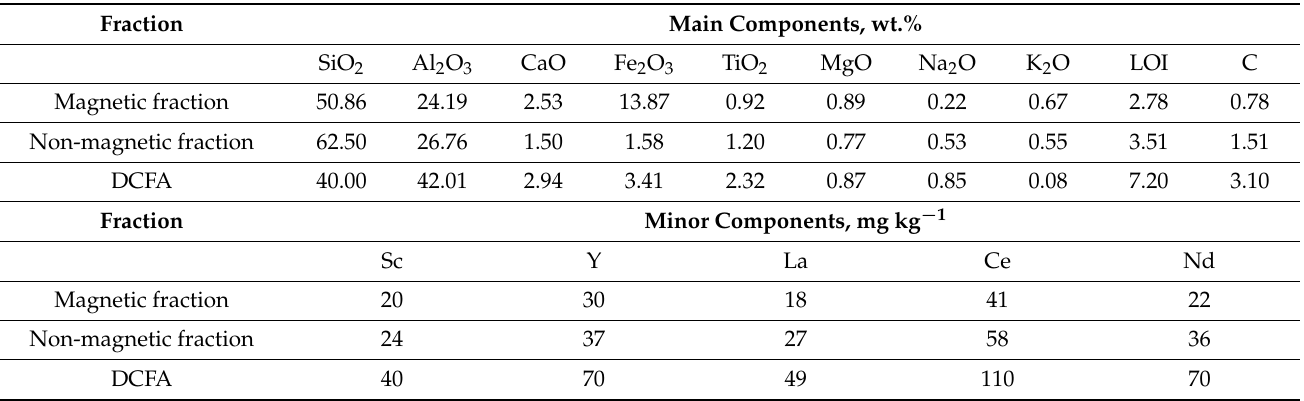
Figure 2. XRD patterns of the raw CFA, magnetic fraction obtained by magnetic separation, and DCFA. Table 2. The chemical composition of the magnetic fraction, non-magnetic fraction before desilication, and the DCFA.